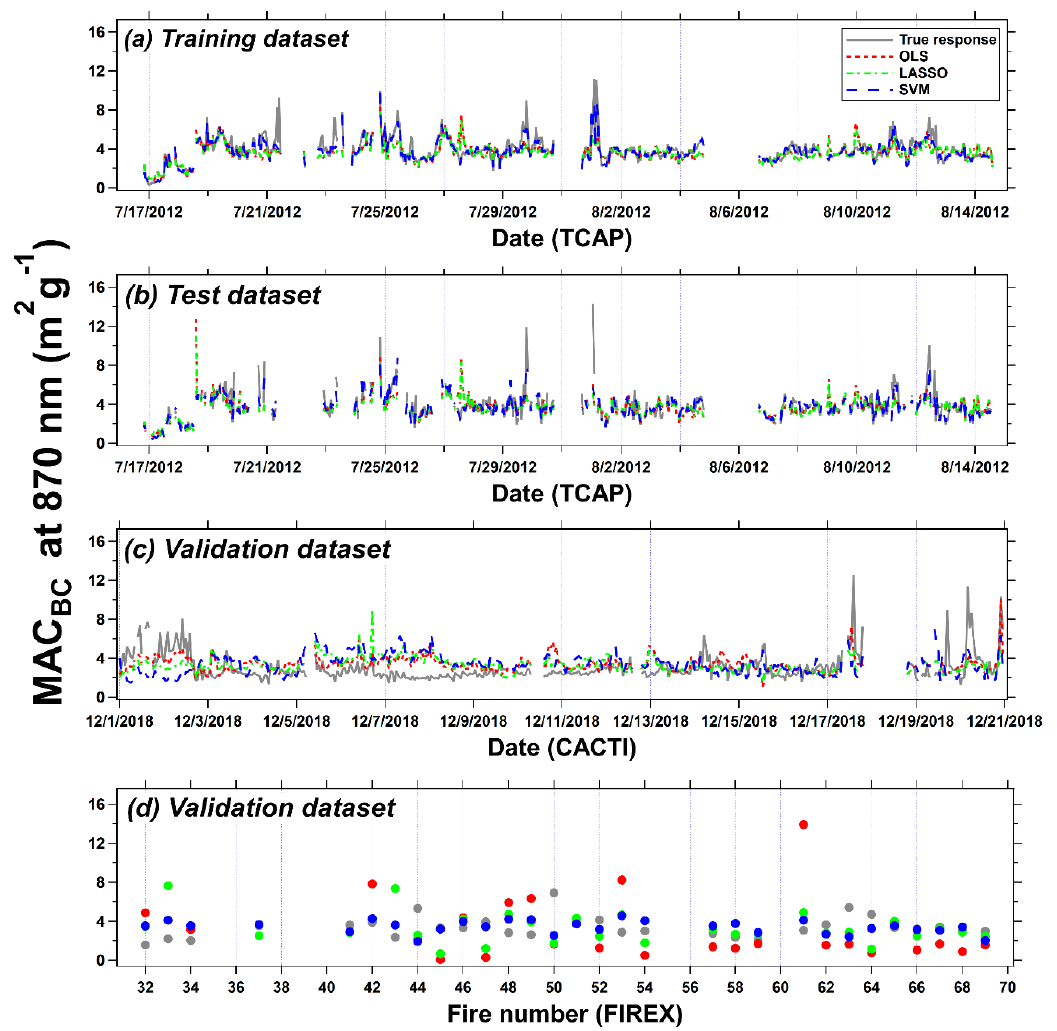
Figure 1. True response and predicted time series of MAC BC using ( a ) training dataset, ( b ) test dataset, ( c ) validation dataset (CACTI), and ( d ) validation dataset (FIREX). Only the curves for three